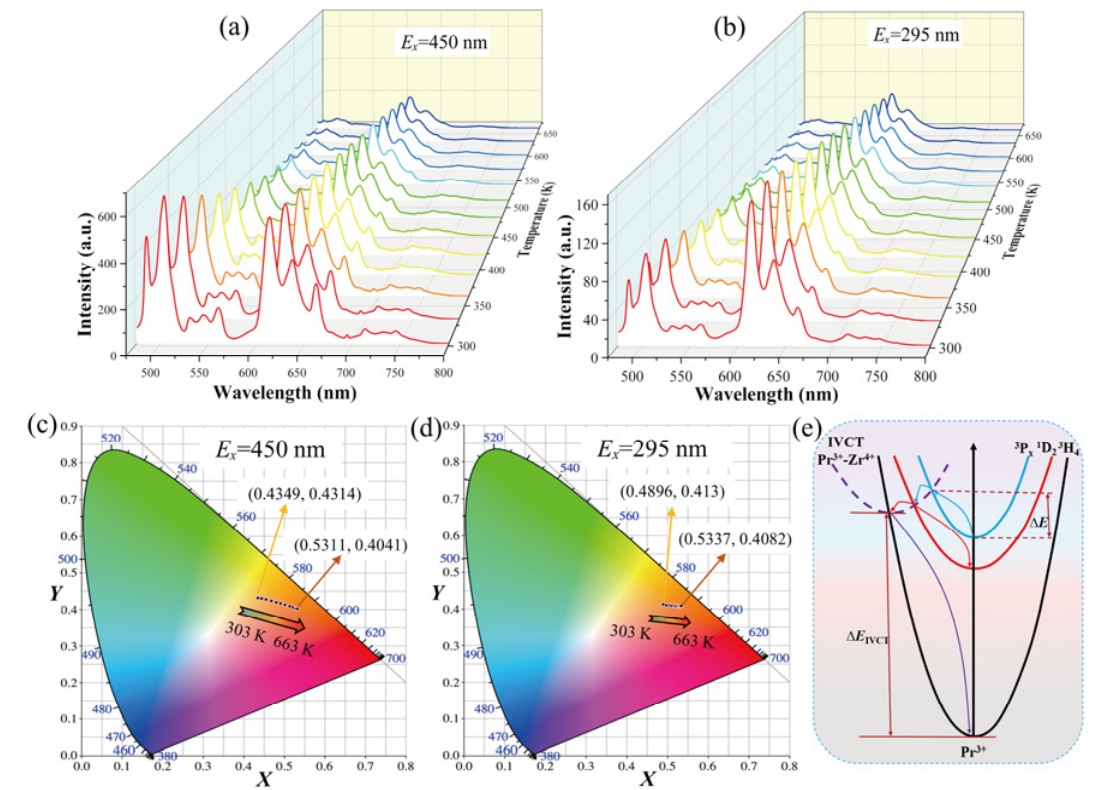
Fig. 5 Temperature-dependent emissions of YZO:0.5Pr ceramic from 303 to 663 K under the excitation of (a) 450 and (b) 295 nm and (c, d) corresponding CIE ( x , y ) coordinate diagrams of the emission colors. (e) Schematic configuration coordinate diagram of the increasing-temperature-induced non-radiative relaxation process of Pr 3+